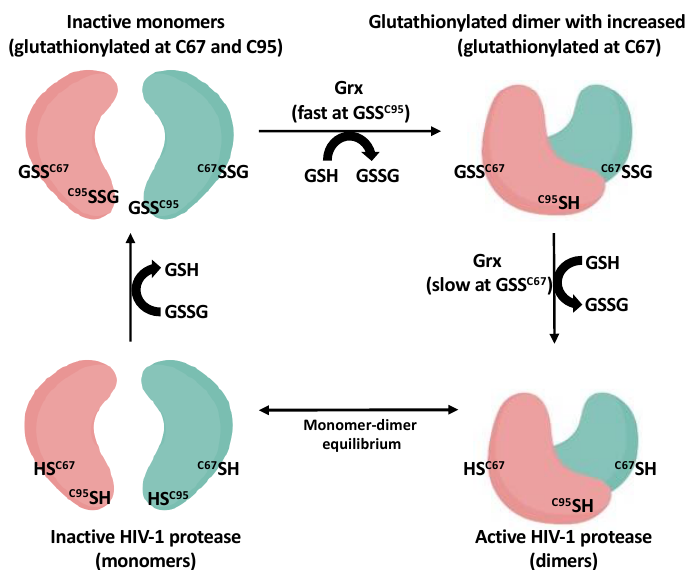
Figure 1. Model depicting HIV-1 protease monomers ( bottom left ) in equilibrium with its active dimer ( bottom right ). GSSG can glutathionylated Cys67 and Cys95 leading to inhibition of dimerization and activity ( top left ). Grx can rapidly remove glutathione from the Cys95 which results in dimerization and increased activity of the protease ( top right ). Grx more slowly removes glutathione from Cys67 producing the unmodified active dimer ( bottom right ).